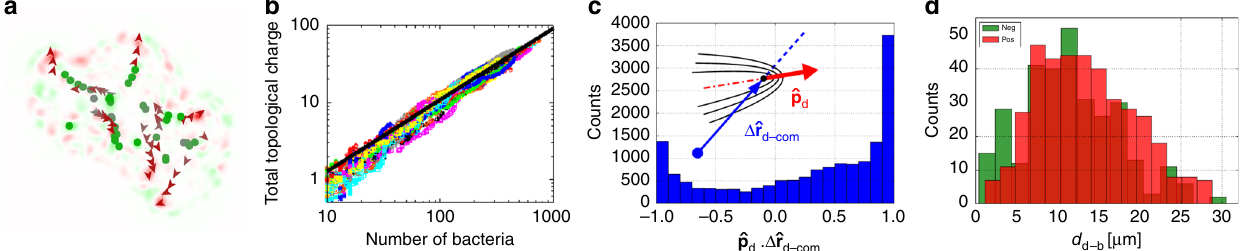
Fig. 4 Topological defects in growing bacterial colonies. a Trajectory of topological defects within one colony. The + 1/2 defects are shown in red, with the arrows denoting polarity, while the − 1/2 defects are shown in green. The markers are increasingly discoloured for earlier times. b Plot of the R q j j d 2 r versus instantaneous number of bacteria in the colony (data for all 32 colonies are included). Solid line, fi t: total unsigned topological charge (cid:2) Δ b r 0.14 N 0.93 , showing that this quantity increases approximately linearly with N . c Histogram of b p for all + 1/2 defects. When this quantity is d (cid:4) com d positive, the corresponding + 1/2 defect is directed outwards with respect to the centre of the colony. [For randomly oriented defects we expect a q ffiffiffiffiffiffiffiffiffiffiffiffiffiffiffiffiffiffiffiffiffiffiffiffiffiffiffiffiffiffiffiffiffiffiffiffiffi Þ 2 .] d Spatial distribution of ± 1 defects as a function of their distance from the buckling point, d d − b , distribution peaked at ±1, and (cid:6) 1 = 2 showing evidence for charge separation, with an excess of (cid:4) 1 defects (green) near d d − b = 2